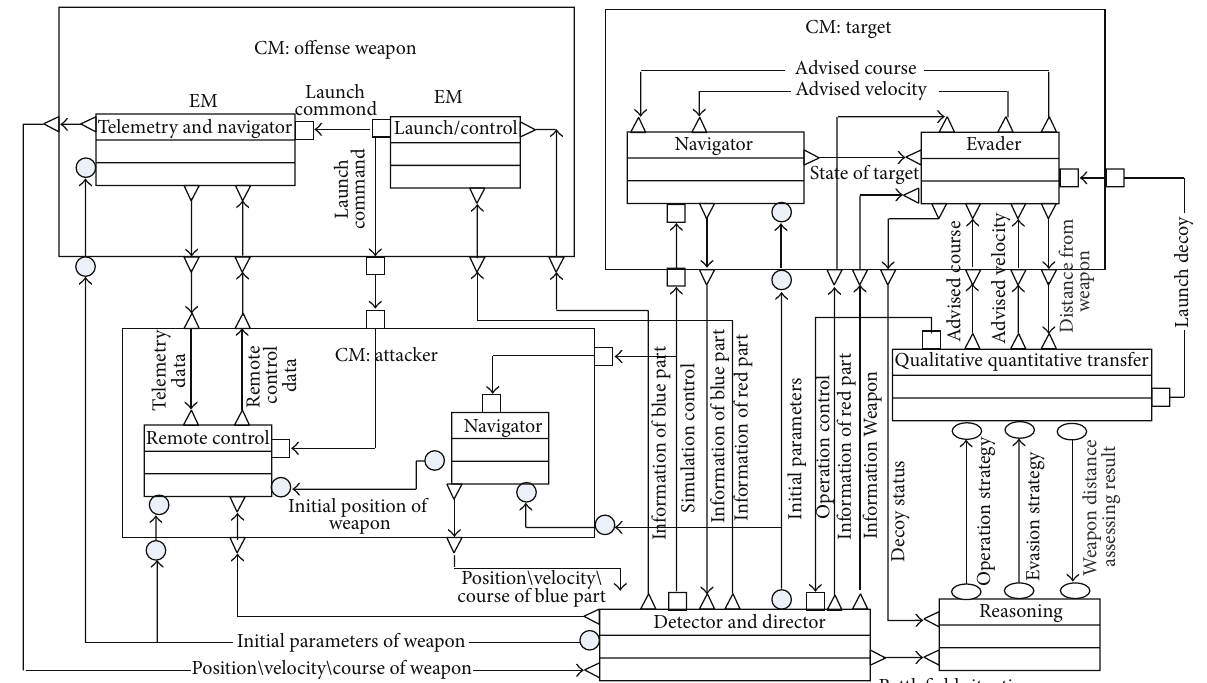
Figure 8: Qualitative and quantitative combined models of the stochastic defense simulation system.